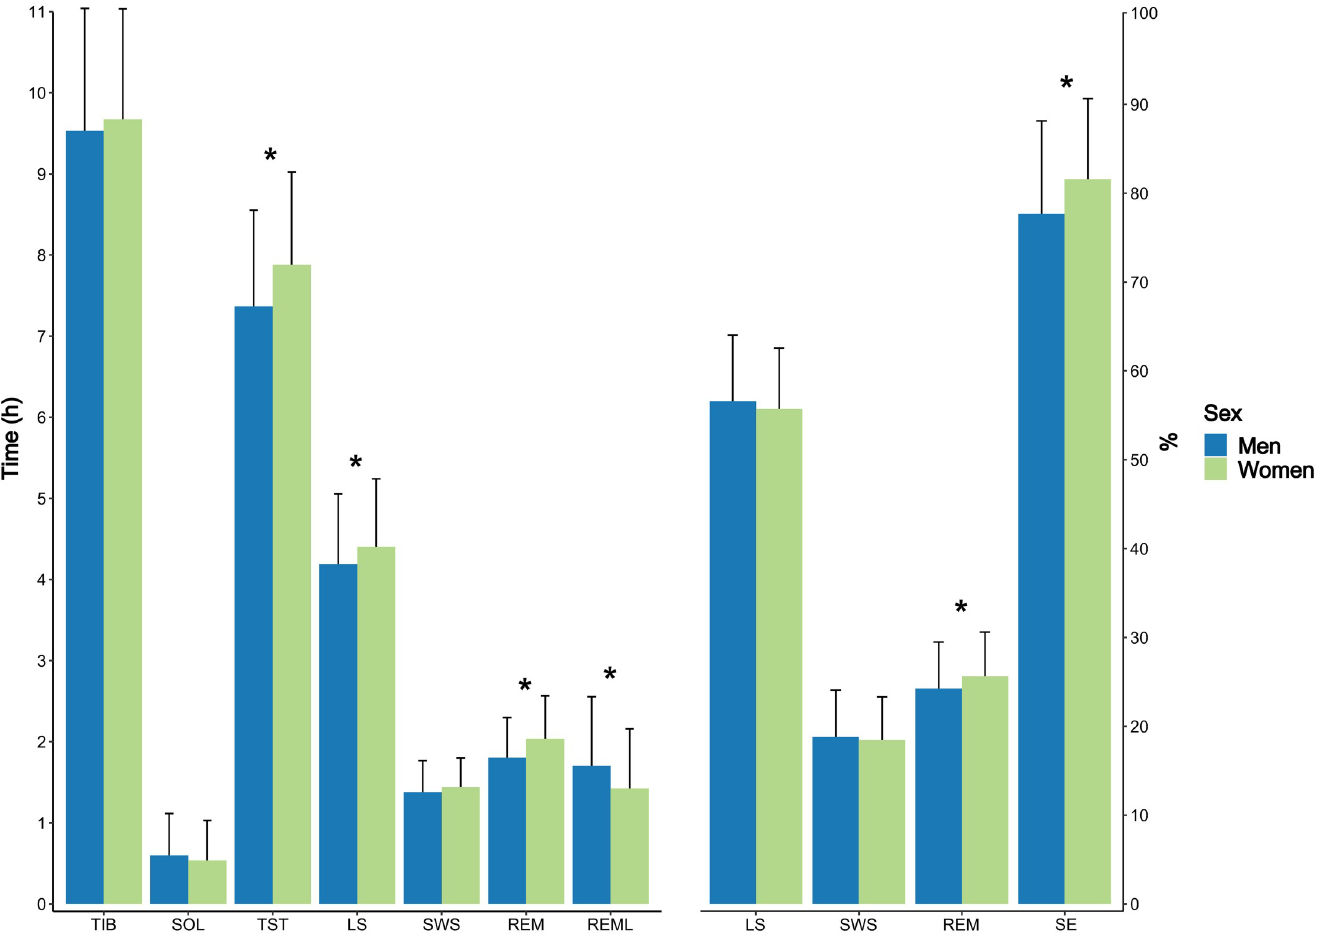
Fig 1. Sex differences in objectively quantified sleep. Abbreviations: TIB = time in bed, SOL = sleep onset latency, TST = total sleep time, LS = light sleep, SWS = deep / slow wave sleep, REM = rapid eye movement sleep, REML = REM latency, SE = sleep efficiency. Blue bars represent men, green bars women. Data is based on 37 male and 19 female junior endurance athletes. Whiskers represent standard deviations. � Represent significant differences between the sexes at p < .05.